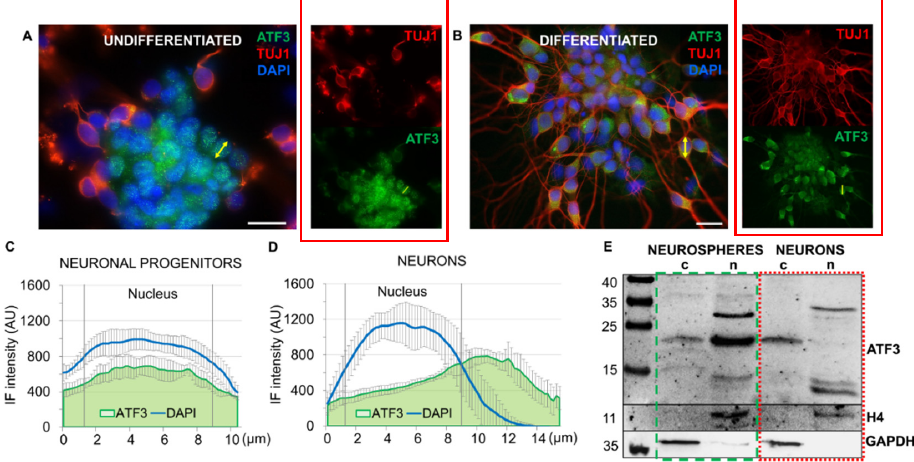
Figure 2. Cellular localization of ATF3 in undifferentiated and differentiated neurospheres. ( A , B ) Immunostaining of primary cortical neurospheres obtained from P5 ‐ 6 opossum cortex: ( A ) undifferentiated neurospheres were cultured in proliferating medium (DMEM/10% FBS) on poly ‐ L ‐ ornithine and fixed at DIV2. ( B ) To induce differentiation, neurospheres cultured in proliferating medium in suspension at DIV3 were transferred on a laminin ‐ coated coverslip, and the medium was switched to neuronal medium for the next 4 days. Cells were fixed at DIV7, and immunostained for ATF3 (green), neuronal cytoskeletal marker β‐ tubulin III (TUJ1, red), and cell nuclei were counterstained with DAPI (blue). ( C , D ) Line scan analysis of primary neuronal progenitors ( C ) and neurons ( D ). Yellow arrows indicate examples of line scan analysis performed on a Z ‐ stack average intensity projection to obtain the plots in which ATF3 (green) and DAPI (blue) are shown in the cytoplasm and nucleus (nuclear region is indicated by the vertical lines). Line plot is the average line intensity of five randomly selected cells. Data are shown as mean ± SD. Scale bar is 20 μ m. ( E ) Western blot analysis of ATF3 levels in the nucleus (N) and cytoplasm (C). The loading controls were GAPDH for the cytoplasmic fractions and Histone H4 for the nuclear fractions.